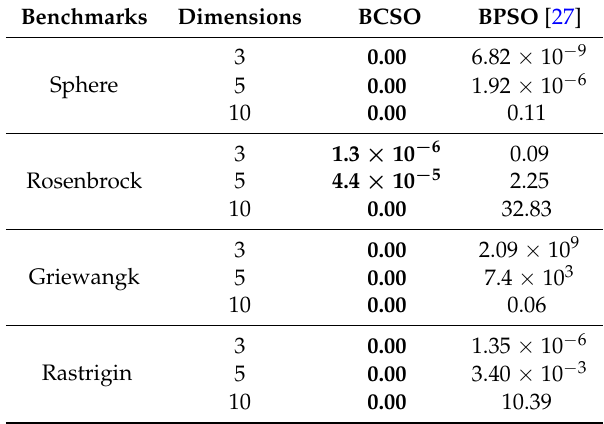
Table 3. Comparison of the mean global best of BCSO and BPSO.